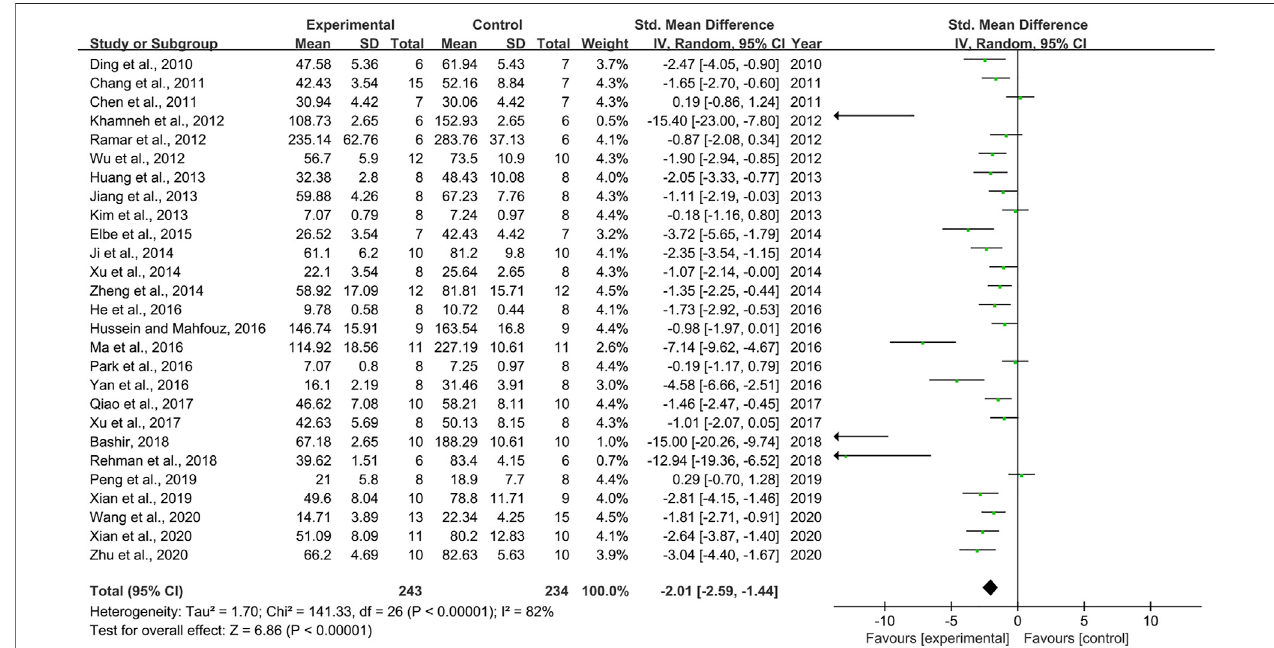
FIGURE 3 | Pooled estimate of Scr with RSV.